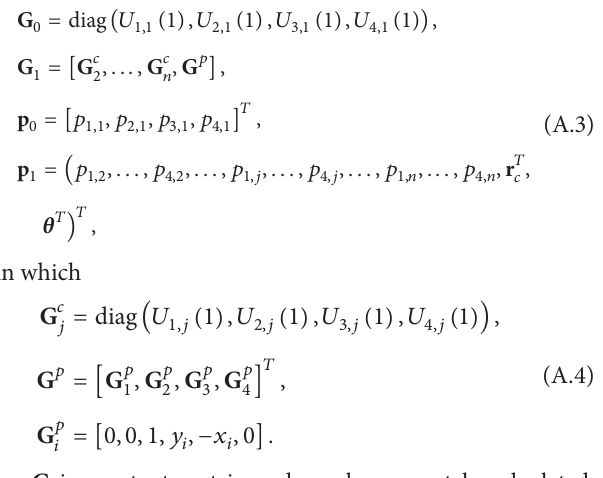
theoretical model and the ADAMS simulation model are both reasonable, and these two models could be adopted independently to study the behavior of